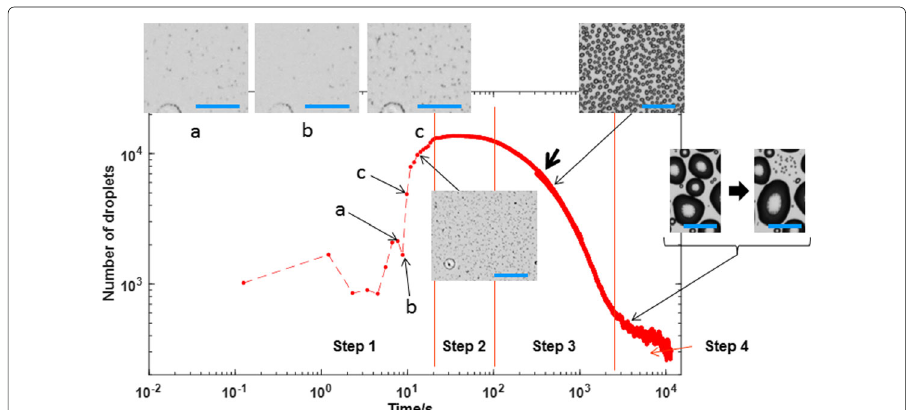
Fig. 4 Number of droplets as a function of time for the 45% relative humidity. The smallest detected droplet diameter is 5 pixels (droplet diameter 6.7 μ m ). Pictures are part of raw images. The scale bar represents 160 μ m . Pictures a , b and c represent evaporation/re-condensation